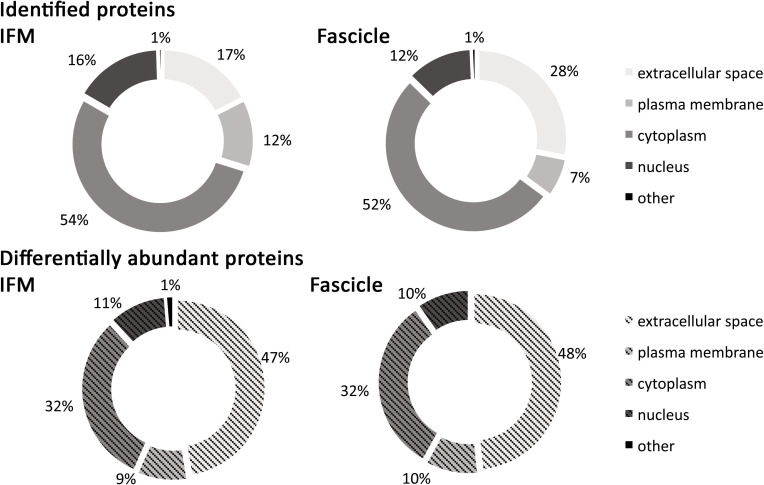
Classification of SDFT IFM and fascicle identified proteins and differentially abundant proteins (p<0.05, fold change ≥2) according to their associated location.